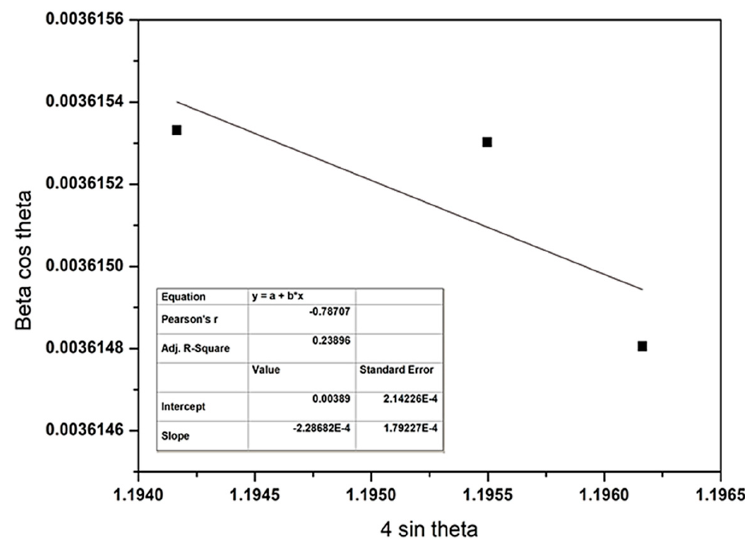
Figure 4. Williamson–Hall plot of as-deposited WS 2 film at 5 sccm of Ar flow rate.